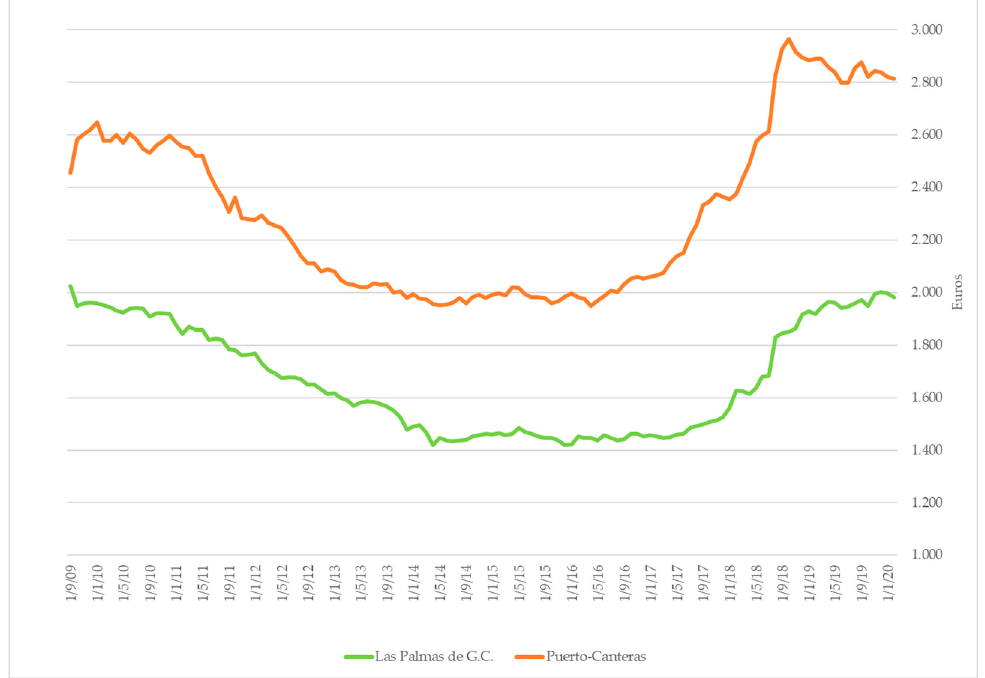
Figure 6. Average price per m 2 in Euros of sales (2009–2019) in Las Palmas de Gran Canaria and Santa Catalina-Canteras. Source: Own elaboration from El Idealista.